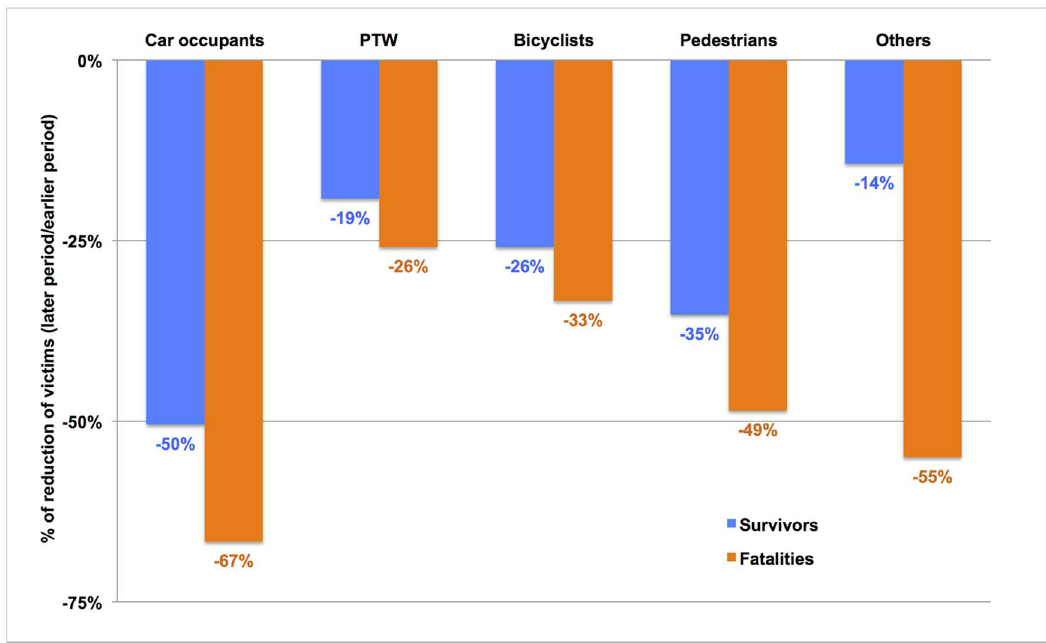
Fig 1. Trends of the TBI victim numbers according to their road user type. Trends of road user types figures (Number in the period2003-2008/number in the period1996–2001) accordingto their deceased(orange)or survivor (blue) status